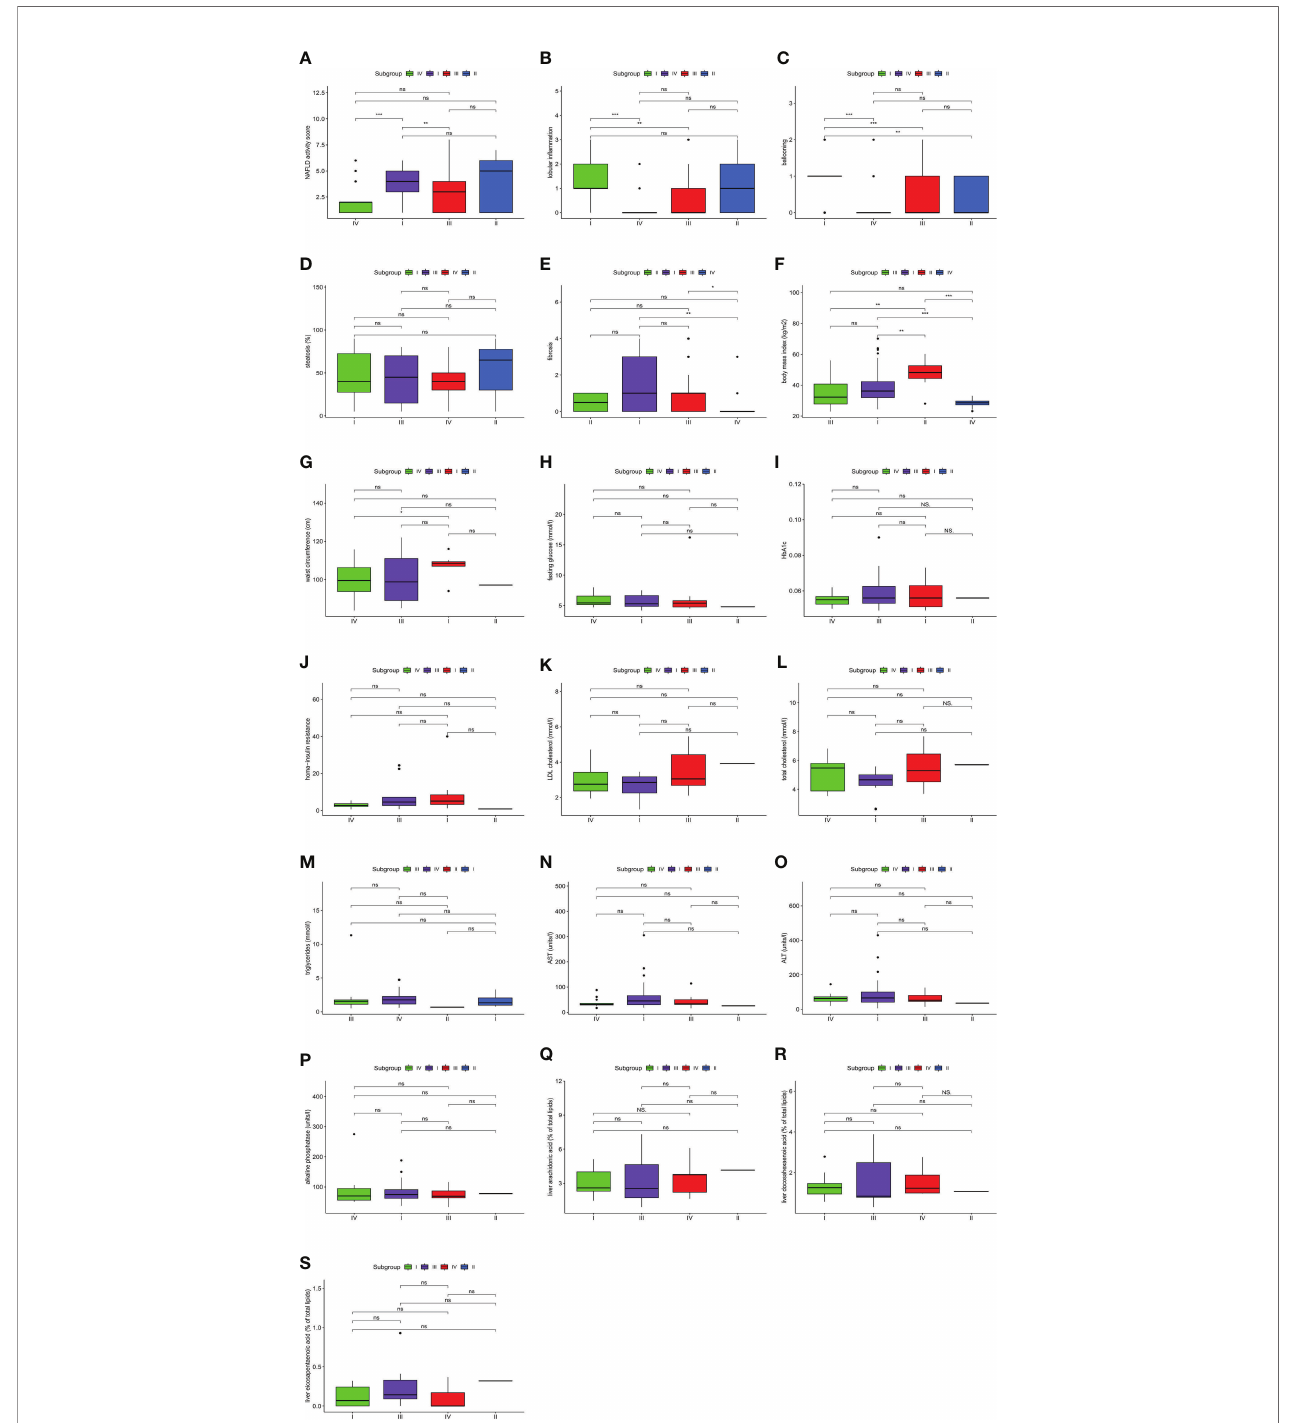
FIGURE 4 | Clinical features of non-alcoholic fatty liver disease (NAFLD). The comparisons of clinical features among four molecular subtypes were conducted based on a pairwise Wilcoxon ’ s rank sum-test. (A) Difference in NAFLD activity score. (B) Difference in lobular in fl ammation. (C) Difference in ballooning. (D) Difference in steatosis. (E) Difference in fi brosis. (F) Difference in body mass index. (G) Difference in waist circumference. (H) Difference in fasting glucose. (I) Difference in HbA1c. (J) Difference in homa-insulin resistance. (K) Difference in LDL cholesterol. (L) Difference in total cholesterol. (M) Difference in triglycerides. (N) Difference in AST. (O) Difference in ALT. (P) Difference in alkaline phosphatase. (Q) Difference in liver arachidonic acid. (R) Difference in liver docosahexaenoic acid. (S) Difference in liver eicosapentaenoic acid. (*P < 0.05; **P < 0.01; ***P < 0.001; ns, not signi fi